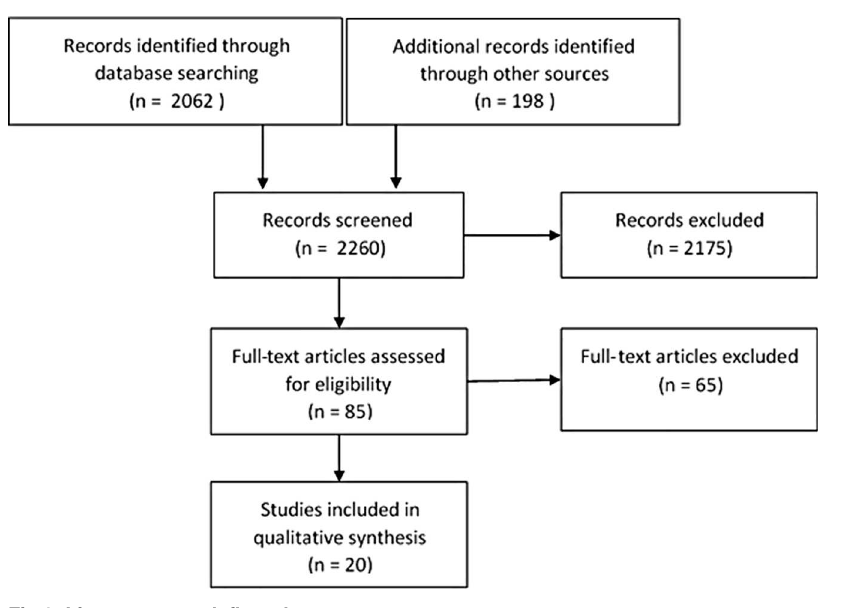
Fig 1. Literature search flow